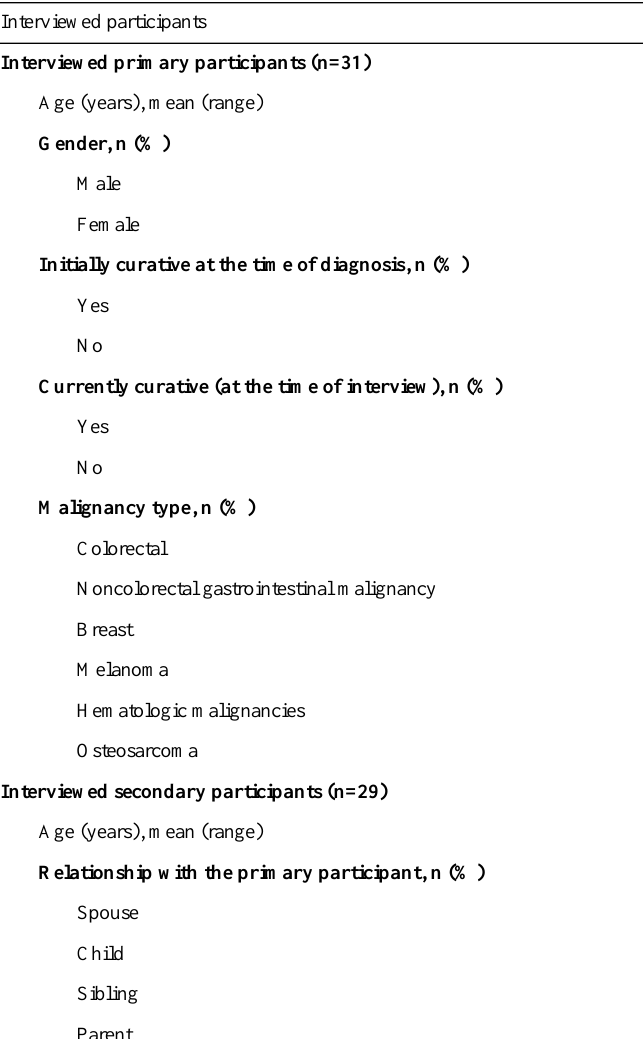
Table 1. Interviewed participants’demographics